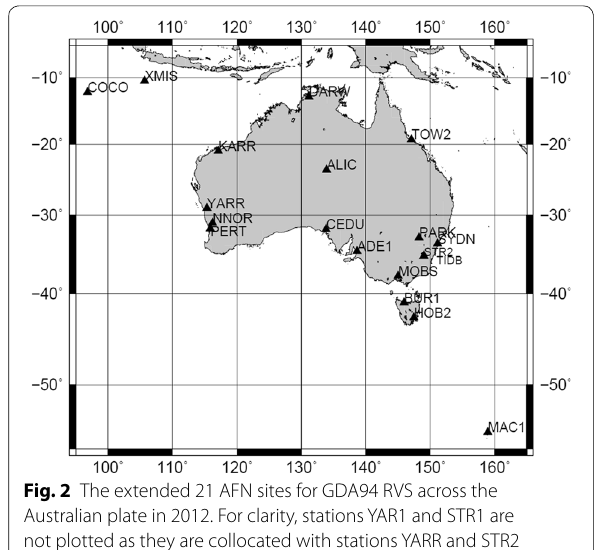
Fig. 2 The extended 21 AFN sites for GDA94 RVS across the Australian plate in 2012. For clarity, stations YAR1 and STR1 are not plotted as they are collocated with stations YARR and STR2